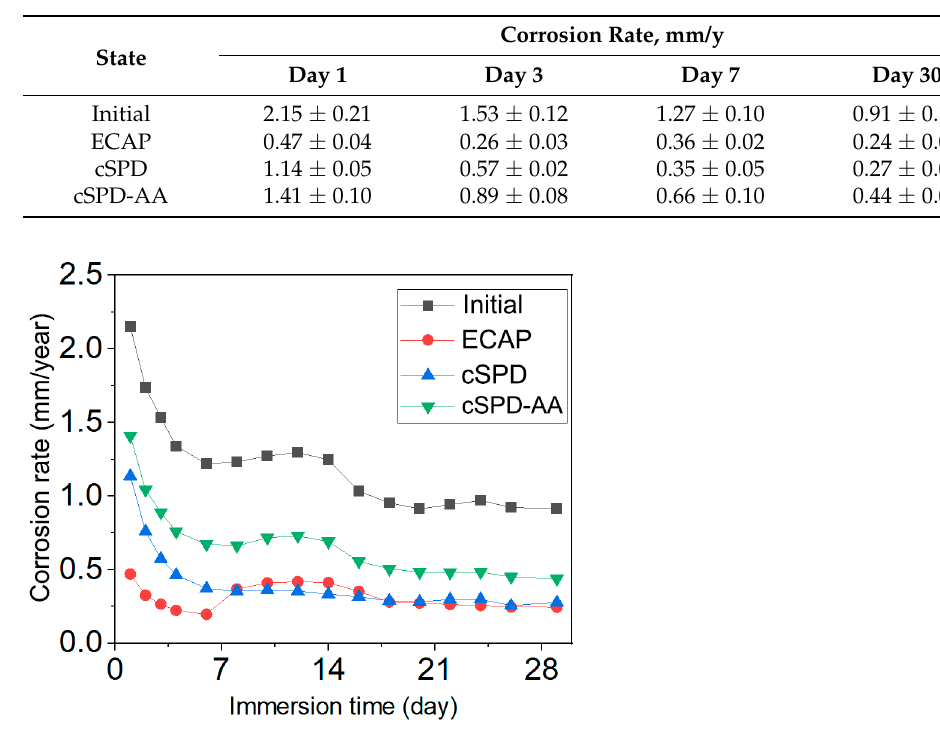
Figure 7. Corrosion rate of the Mg-2Sr alloy in different structural states after immersion in Ringer’s solution for exposure time up to 30 days. Table 3. Corrosion rates of the Mg-2Sr alloy in different structural states.